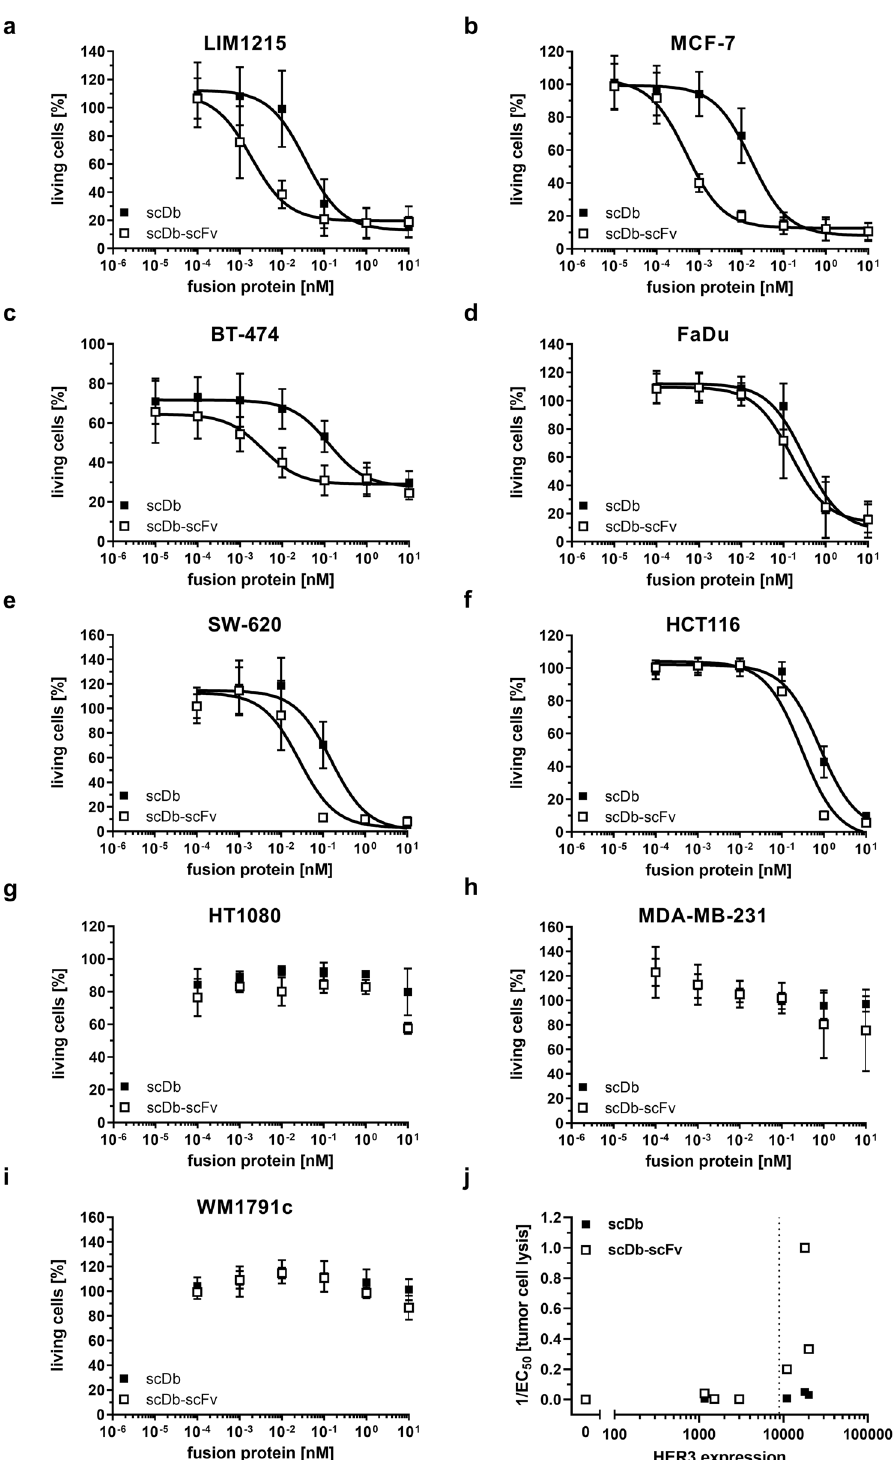
Figure 4. Effect of scDb and scDb-scFv on cytotoxic potential of PBMCs. Target cells (( a ) LIM1215, ( b ) MCF-7, ( c ) BT-474, ( d ) FaDu, ( e ) SW-620, ( f ) HCT116, ( g ) HT1080, ( h ) MDA-MB-231 or ( i ) WM1791c cells) were incubated with a serial dilution of scDb or scDb-scFv and PBMCs in an effector:target cell ratio (E:T) of 10:1. After 3 days, cell viability was determined using crystal violet staining. Mean ± SD. On the low expressing cell lines SW-620, HCT116, HT1080, MDA-MB-231 and WM1791c three independent experiments (n = 3) were performed using PBMCs from one donor. On the cell lines LIM1215, MCF-7, BT-474 and FaDu three independent experiments for each donor using PBMCs from two different donors were performed (n = 6). In total, PBMCs from 5 different donors were used. ( j ) Potency of scDb and scDb-scFv versus HER3